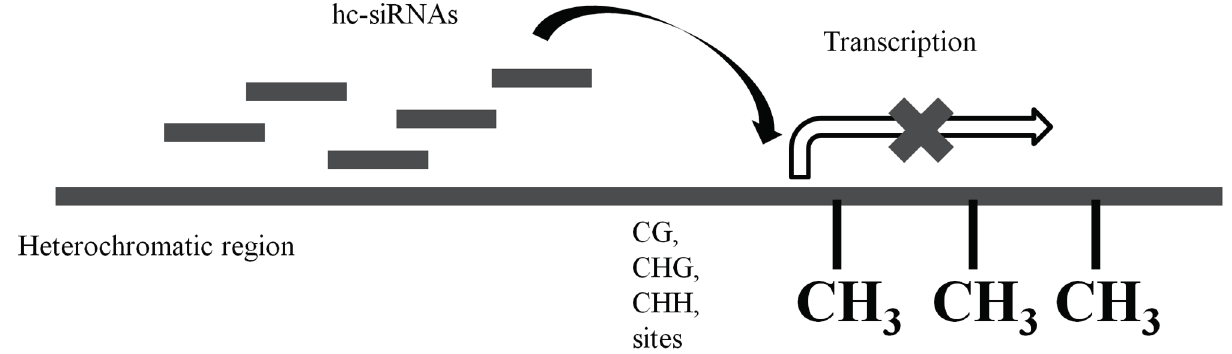
Figure 2. hc-siRNAs are transcribed at the heterochromatic regions where they act